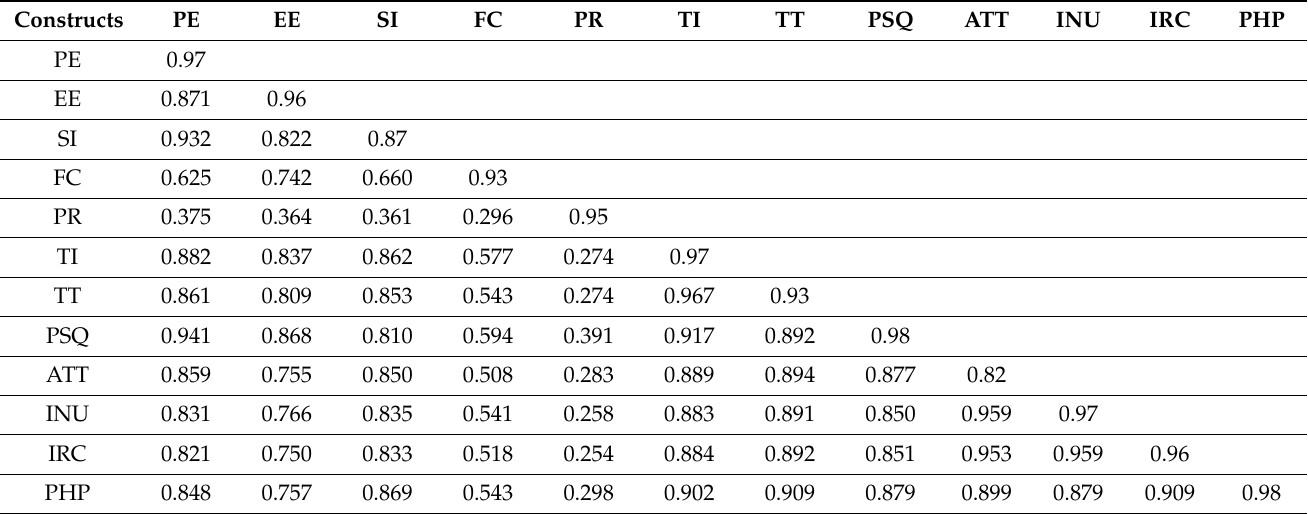
Table 5. Correlations of